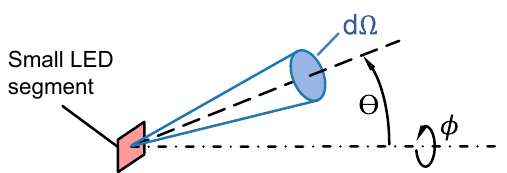
Figure 5. Definitions of the azimuthal angle (cid:50) , polar angle φ and differential solid angle d (cid:127) for the light emission of a small LED segment.